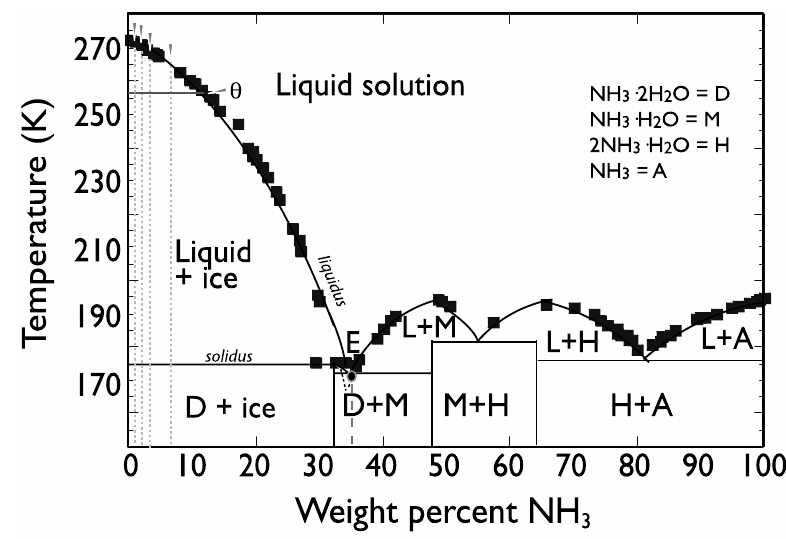
Figure 1. Annotated equilibrium phase diagram for H 2 O–NH 3 at P = 1 atm. Data comes from [2] and references therein. Dashed vertical lines represent bulk compositions of samples used for P-wave velocity measurements in this study. Horizontal line represents isotherm at which dihedral angle was measured in this study.